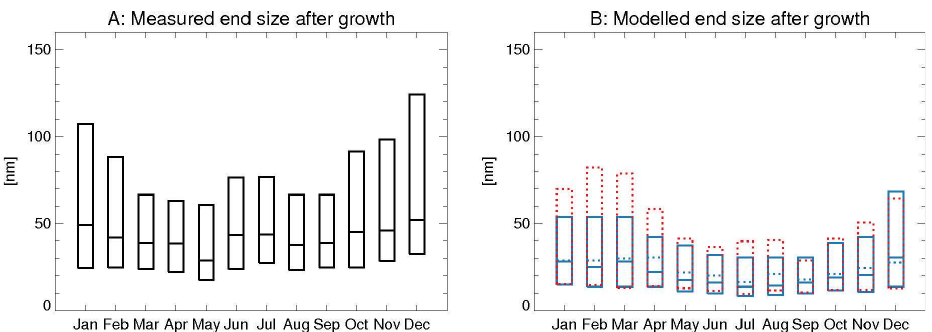
Fig. 9. Smallest, mean and max size of growing nucleation mode at the end of the event (A) in observations; and (B) simulations with kinetic sulphuric acid nucleation (Eq. 1) and the standard secondary organics scheme. Dashed bars on the right represent end-sizes assuming both sulphuric acid and secondary organics nucleation (Eq. 2) and doubled secondary organics